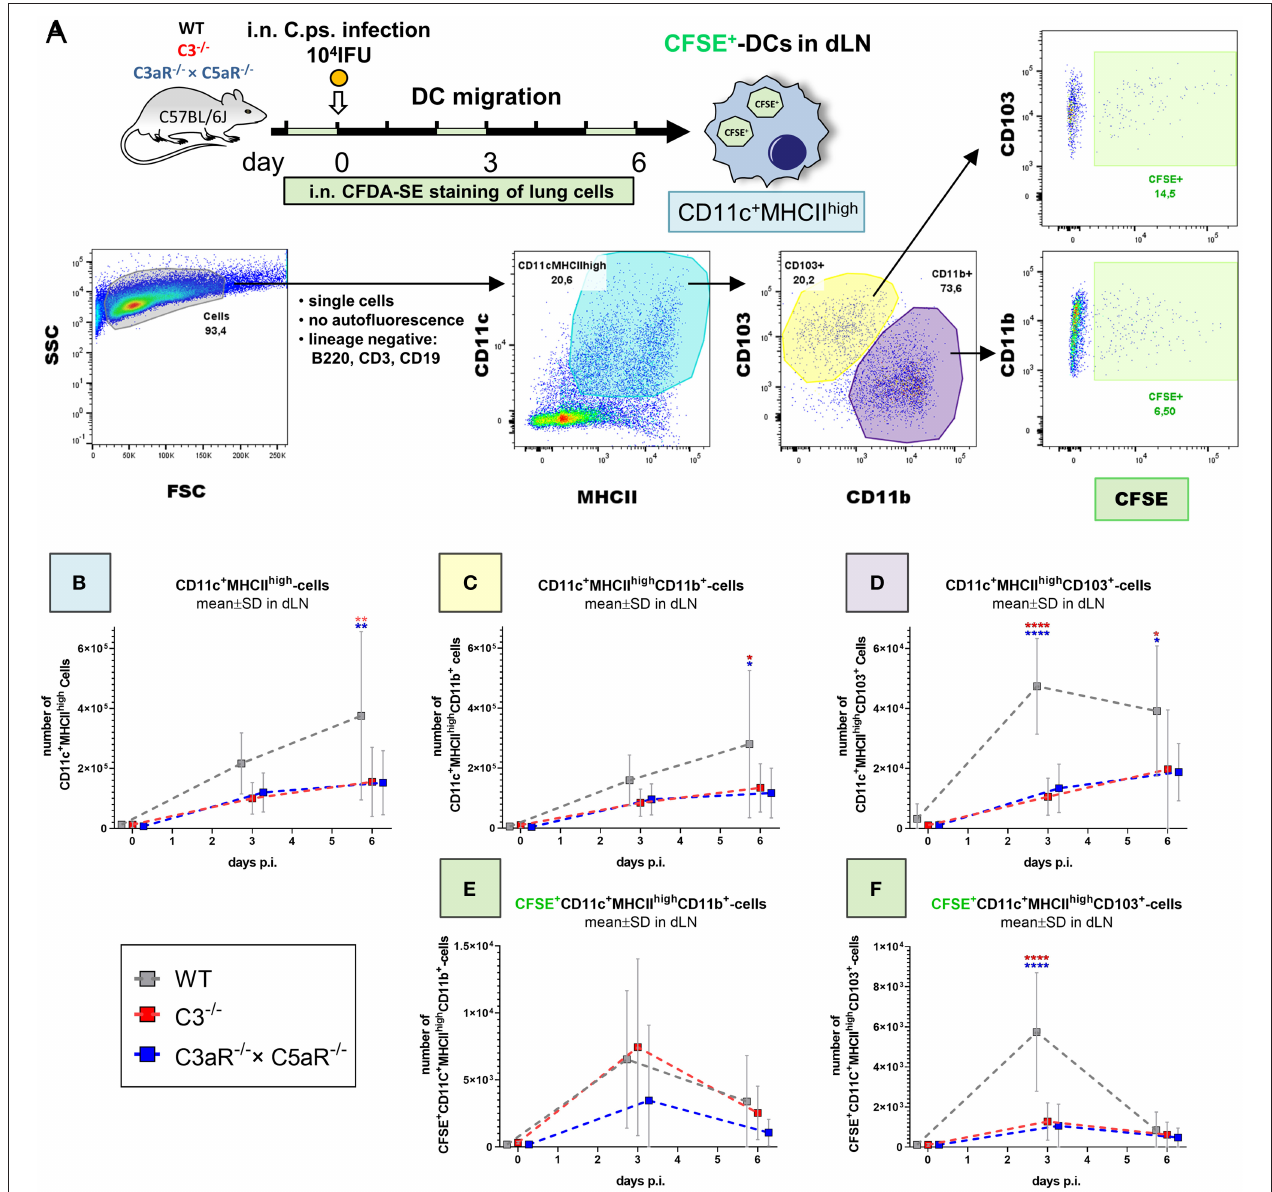
FIGURE 5 | Migration of DCs from the C. psittaci infected lung to dLN depends on C3 as well as C3aR (and C5aR1). DC migration to the dLN was assessed on day 0 (i.e., directly before), 3 and 6 of C.ps. infection (10 4 IFU of Chlamydia). Considering isotype and FMO controls and distinguishing between CD103 + and CD11b + subsets, DCs were identified as lineage negative non-auto-fluorescent CD11c + MHCII high -expressing cells. Applying i.n. in vivo staining of lung cells 1 day before analysis, lung DCs which had migrated during the last ∼ 24h could be identified as CFSE + cells in the dLN (as explained by the scheme in (A) . The numbers of CD11c + MHCII high (B) , CD11c + MHCII high CD11b + (C) , and CD11c + MHCII high CD103 + (D) DCs in steady state were determined at the indicated time-points p.i. The kinetic of migratory lung CFSE + -CD11b + - and CD103 + DCs in dLN is depicted in the lower two panels (E,F) . Statistical analysis was performed by One-way ANOVA followed by Bonferroni post-test. Statistical significance was displayed according to the calculated p -value: * p ≤ 0.0332; ** p ≤ 0.0021; *** p ≤ 0.0002; **** p ≤ 0.0001. Illustrations were partially created using templates from www.motifolio.com. DC, dendritic cell; FMO, fluorescence minus one